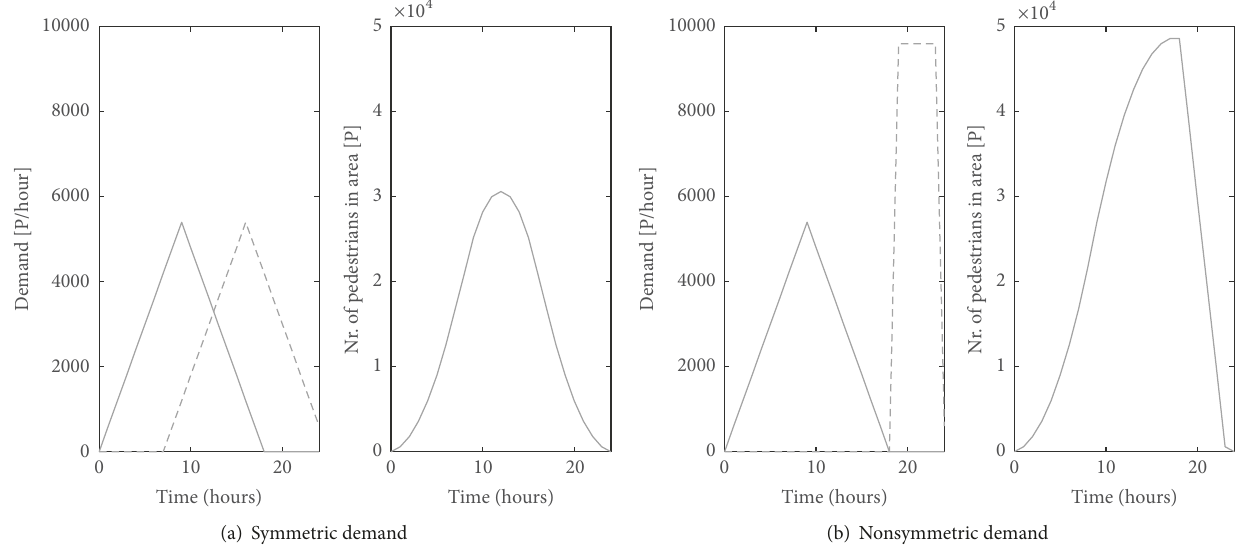
Figure 4: Visualisation of the demand at both entrances (left) and cumulative number of pedestrians in the region (right), where (a) illustrates the symmetric demand case and (b) the nonsymmetric demand case. The solid line represents the inflow, while the dashed line indicates the outflow.